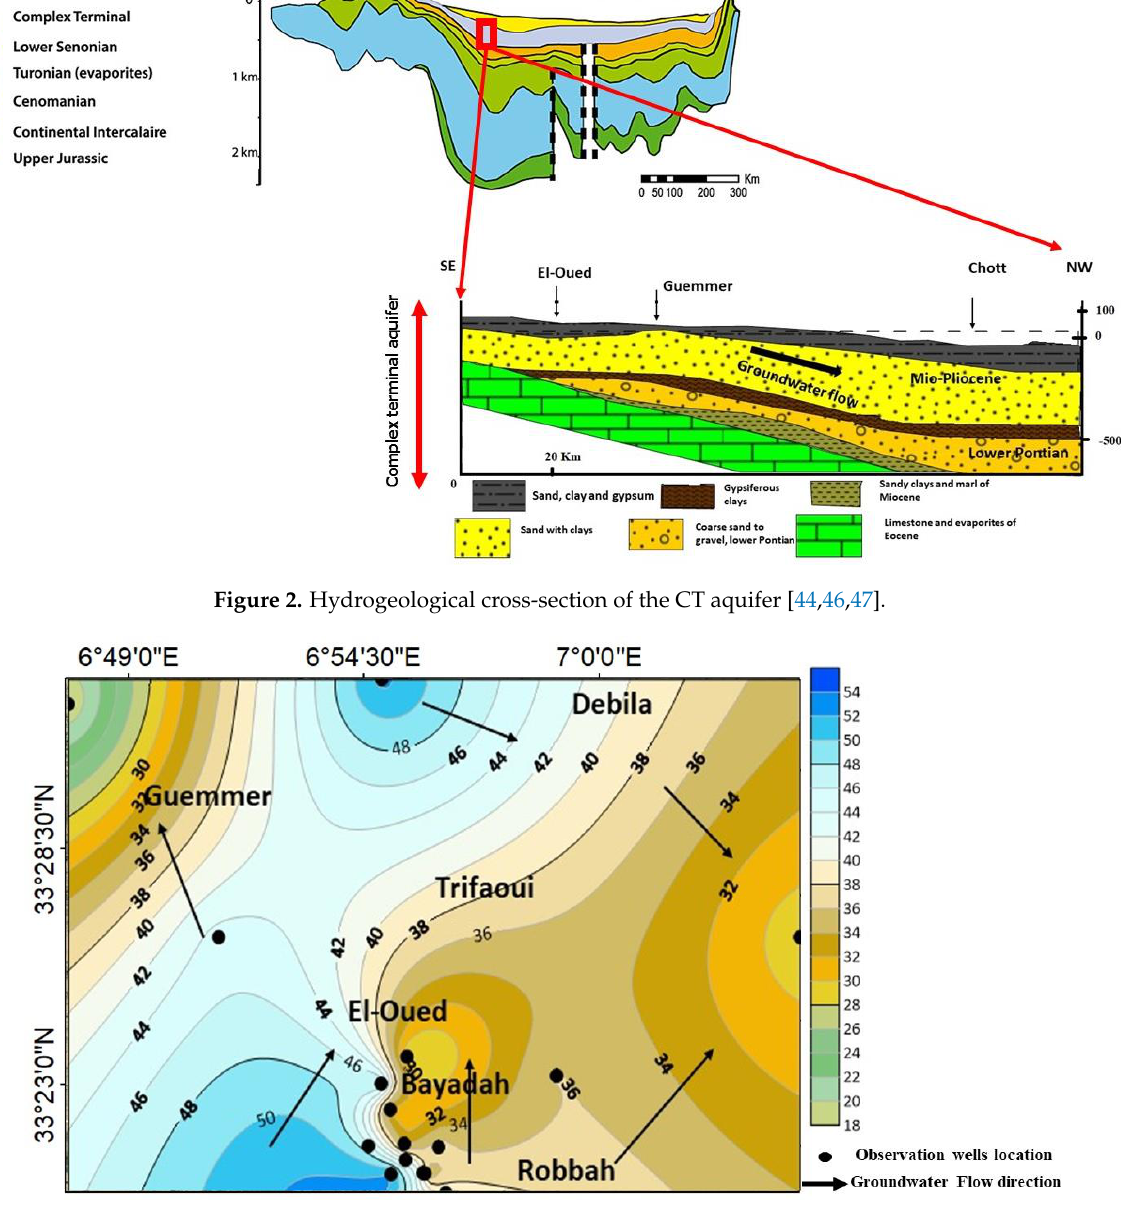
Figure 3. Groundwater flow direction from a Piezometric map of the CT aquifer.